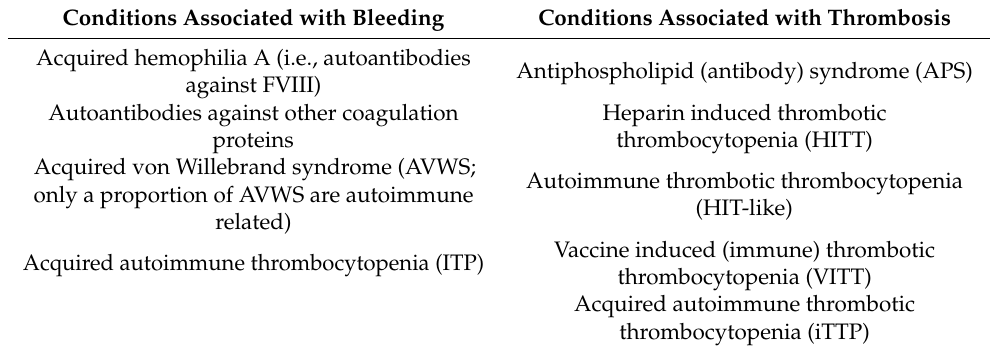
Table 2. Summary of major autoimmune conditions associated with bleeding or